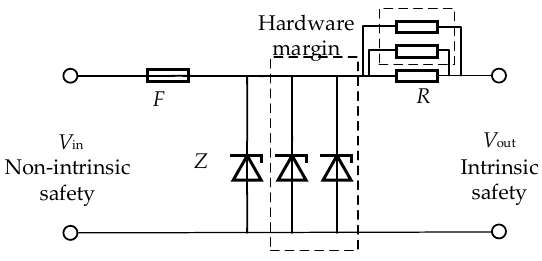
Figure 4. Intrinsically safe protection circuit.